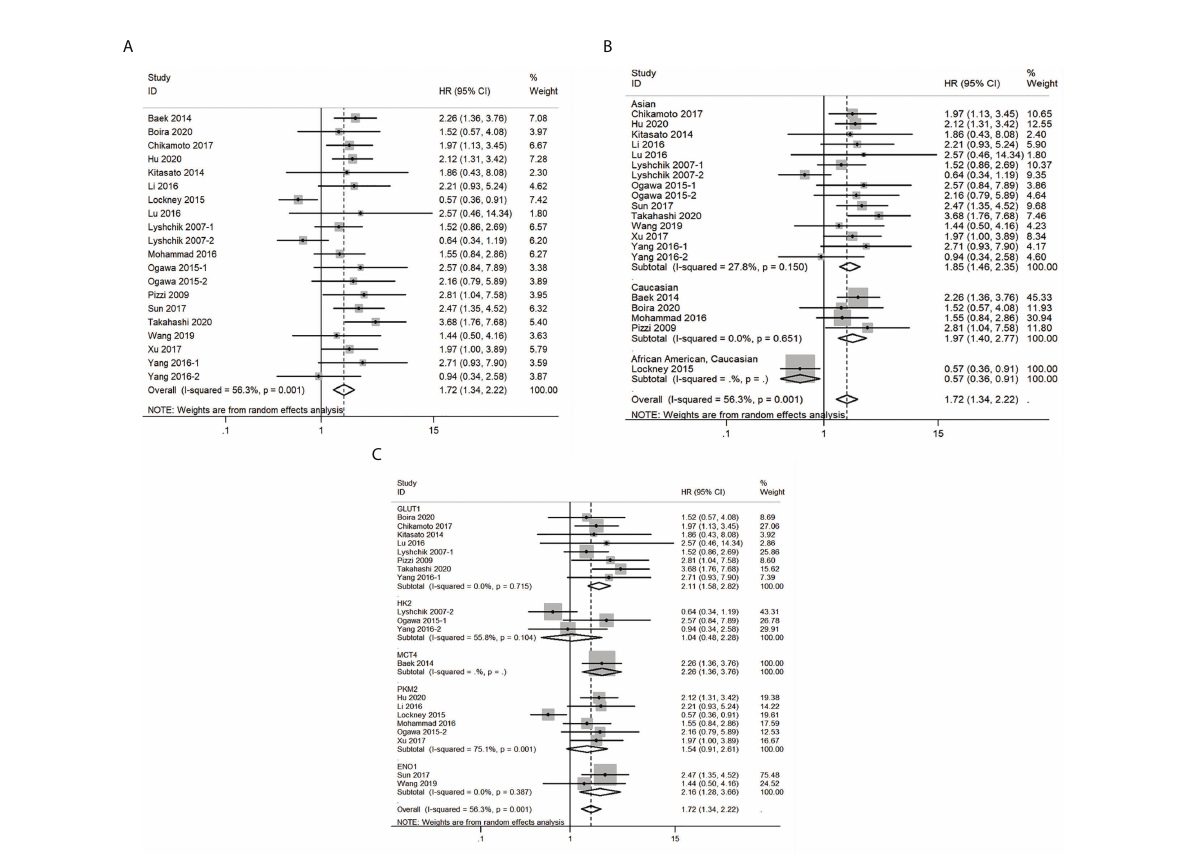
FIGURE 4 Forest plots of pooled hazard ratio (HR) for the association between the expression levels of glycolysis markers and overall survival of pancreatic cancer patients. (A) The overall group; (B) Subgroup analysis for ethnicity; (C) Subgroup analysis for glycolysis markers types. A random-effects model was